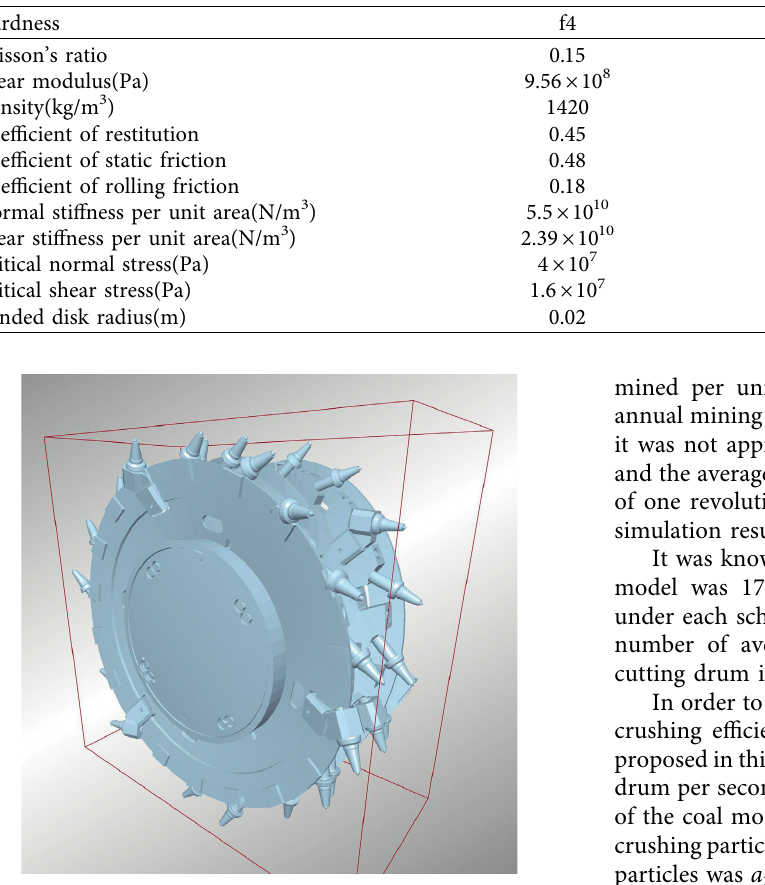
Figure 6: Simplified drum